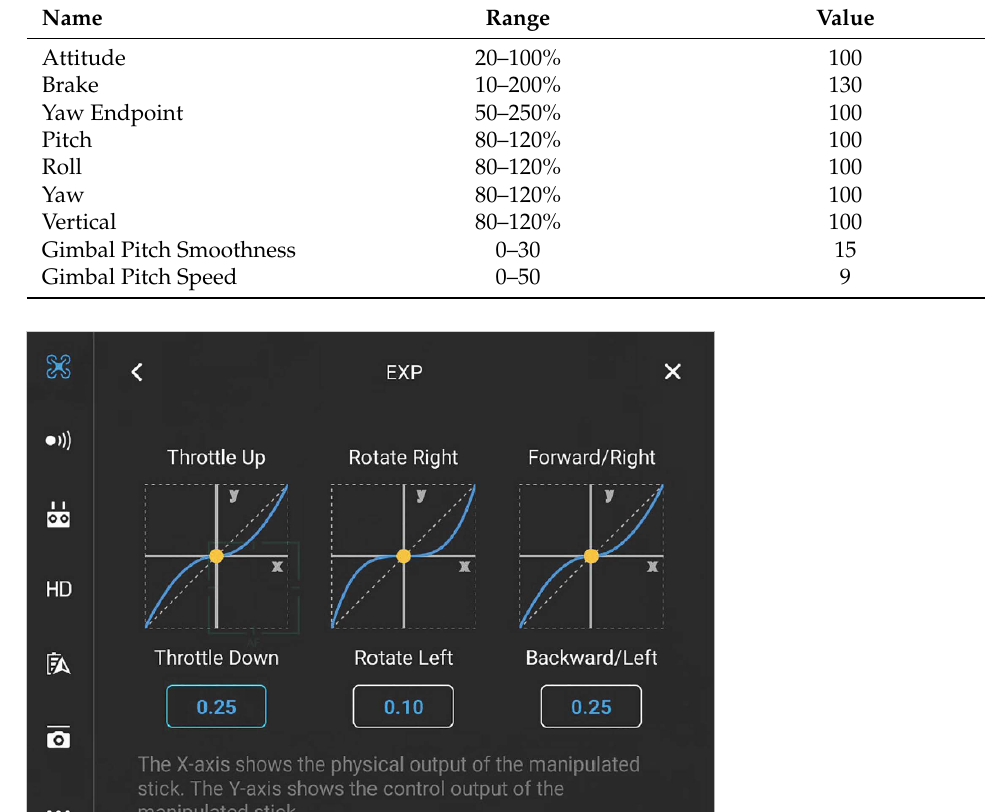
Table 1. Device parameter values; Source: own study.